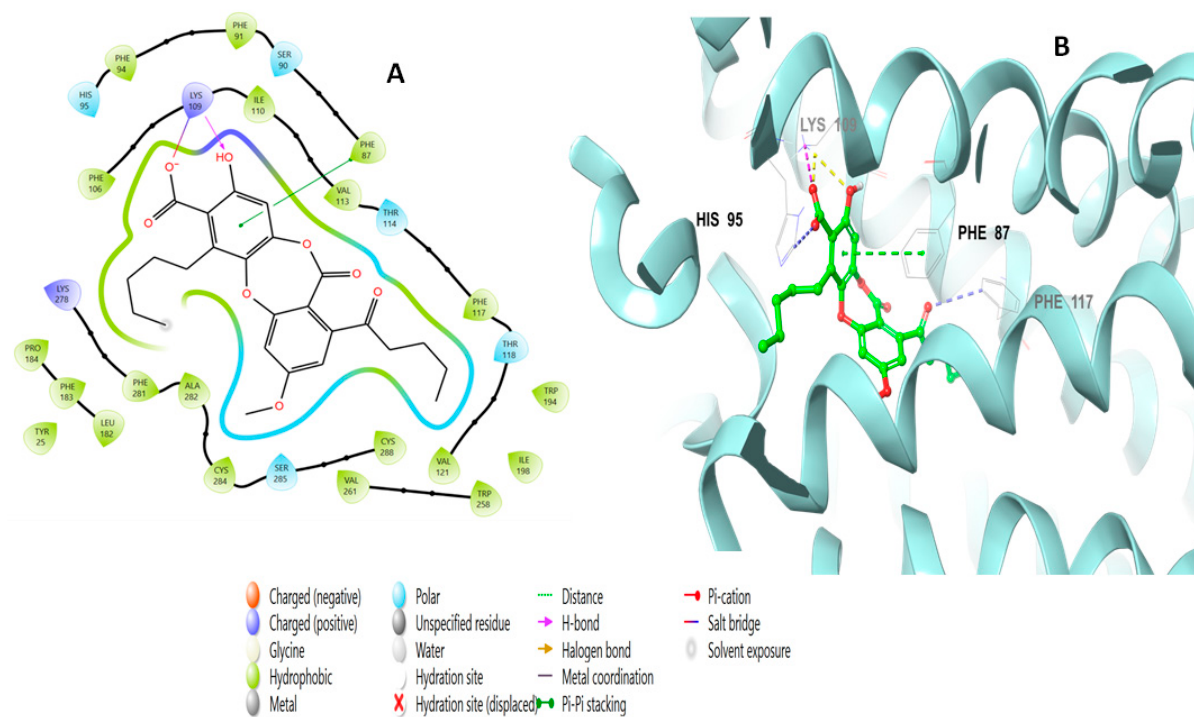
Figure 7. Putative binding mode of lobaric acid ( 110 ) at the binding site of CB2 receptor (PDB ID: 6KPF). Lobaric acid ( 110 ) is displayed as green sticks. H bonds are displayed as yellow dotted lines, and ionic bonds as blue dotted lines. ( A ) Two-dimensional view; ( B ) three-dimensional view of CB2 complexed with lobaric acid ( 110 ).